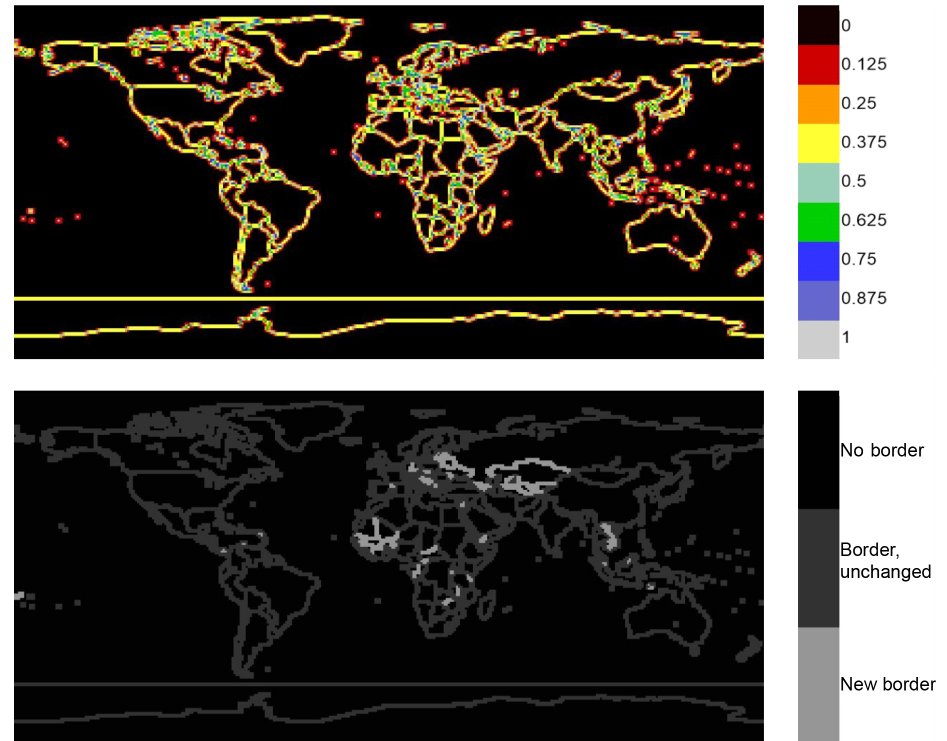
Figure 7. Geography map uncertainty assessment examples. The top plot is for the year 1950 and its key shows the uncertainty as a fraction. The bottom plot shows the 1950–2011 differences. A difference plot was shown because only 749 cells (about 1% of 64800 total cells) changed value between 1950 and